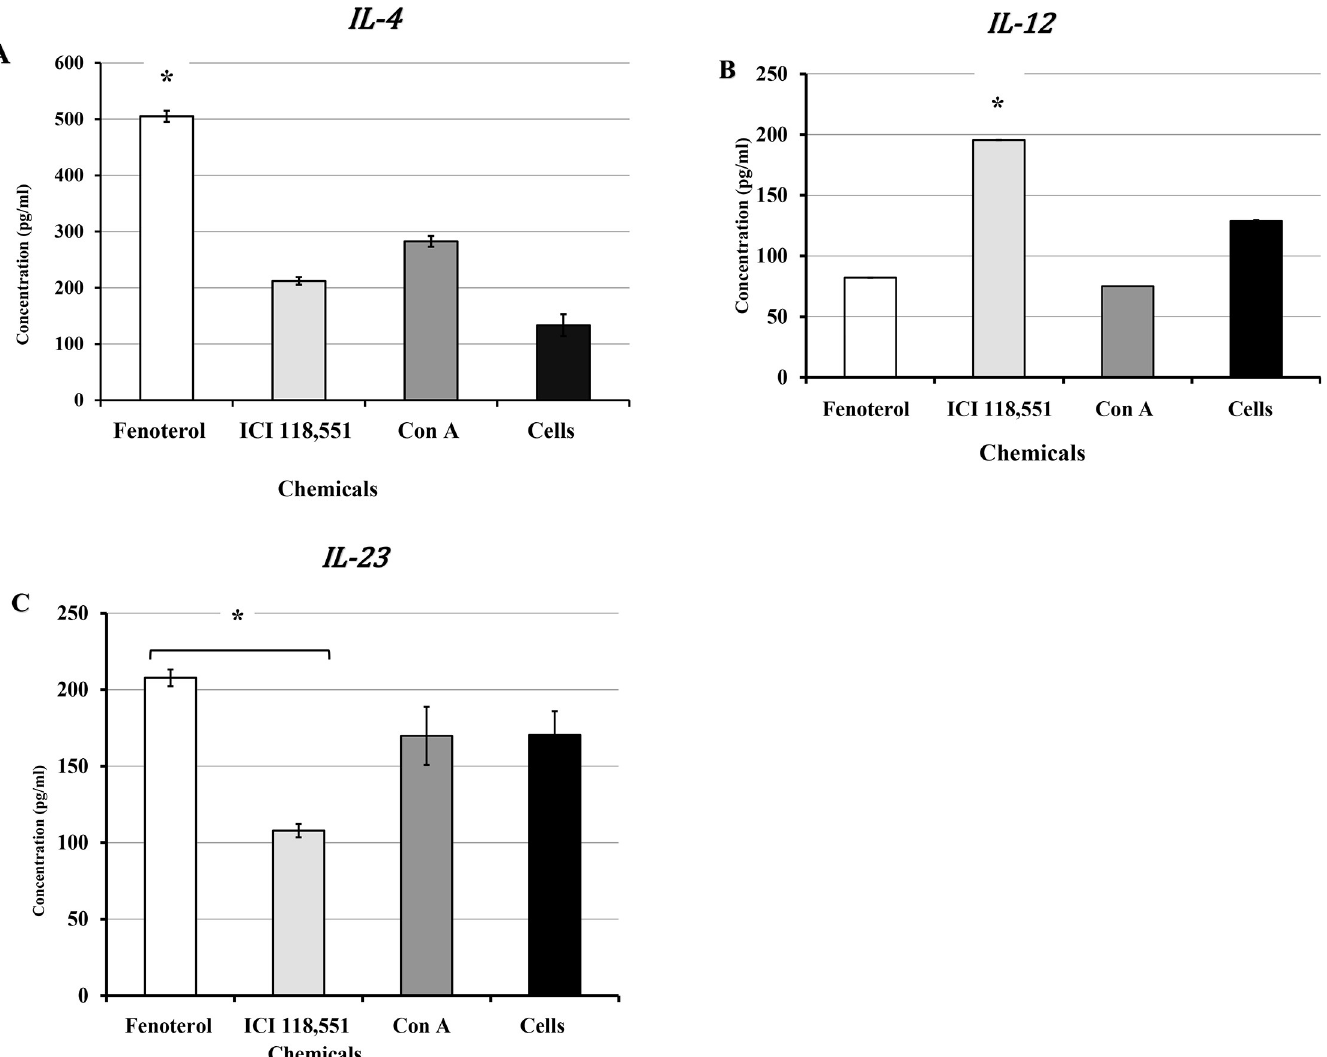
Fig 6. Presence of β 2-AR agonist or antagonist on in vitro production of A ) IL-4, B ) IL-12, and C ) IL-23 in na ï ve CD4 T-cells isolated from stressed non-infected mice. Immature dendritic cell culture was pre-exposed to NE (1 μ M), Fenoterol (1 μ M) and ICI 118,551 (1 μ M) for 1 h before stimulation with LPS (5 μ g/mL) for 24 h before RNA isolation. Data shown are a mean +/_ SEM of two or more independent experiments performed on different dates. � Denotes significant statistical differences between treatment groups at the level of (p < 0.05).